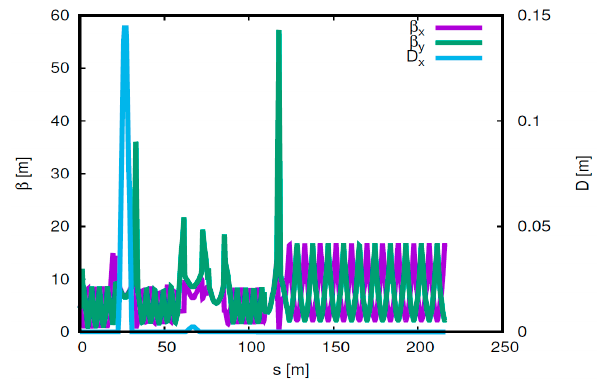
Figure 3. From top to bottom, electron beam mean energy, rms bunch duration, betatron, and dispersion functions along the CompactLight accelerator. Soft and hard x-ray operation at repetition rates in the 0.1–1 kHz range is illustrated. Bunch durations correspond to the nominal bunch charge of 75 pC and to the final peak current of 0.35 kA and 4.5 kA. The soft x-ray operation at 0.1 kHz foresees beam extraction from the main linac at the intermediate energy of 2 GeV.